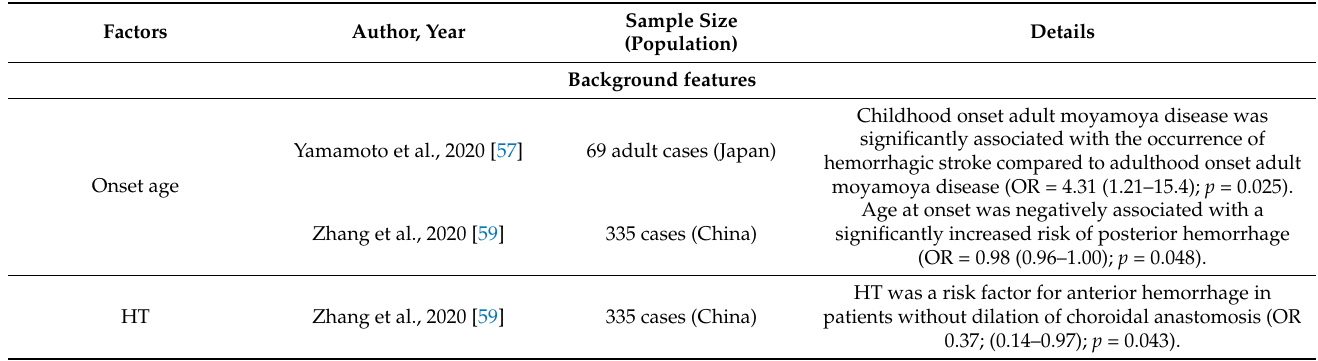
Table 4. Clinical factors associated with hemorrhagic onset moyamoya